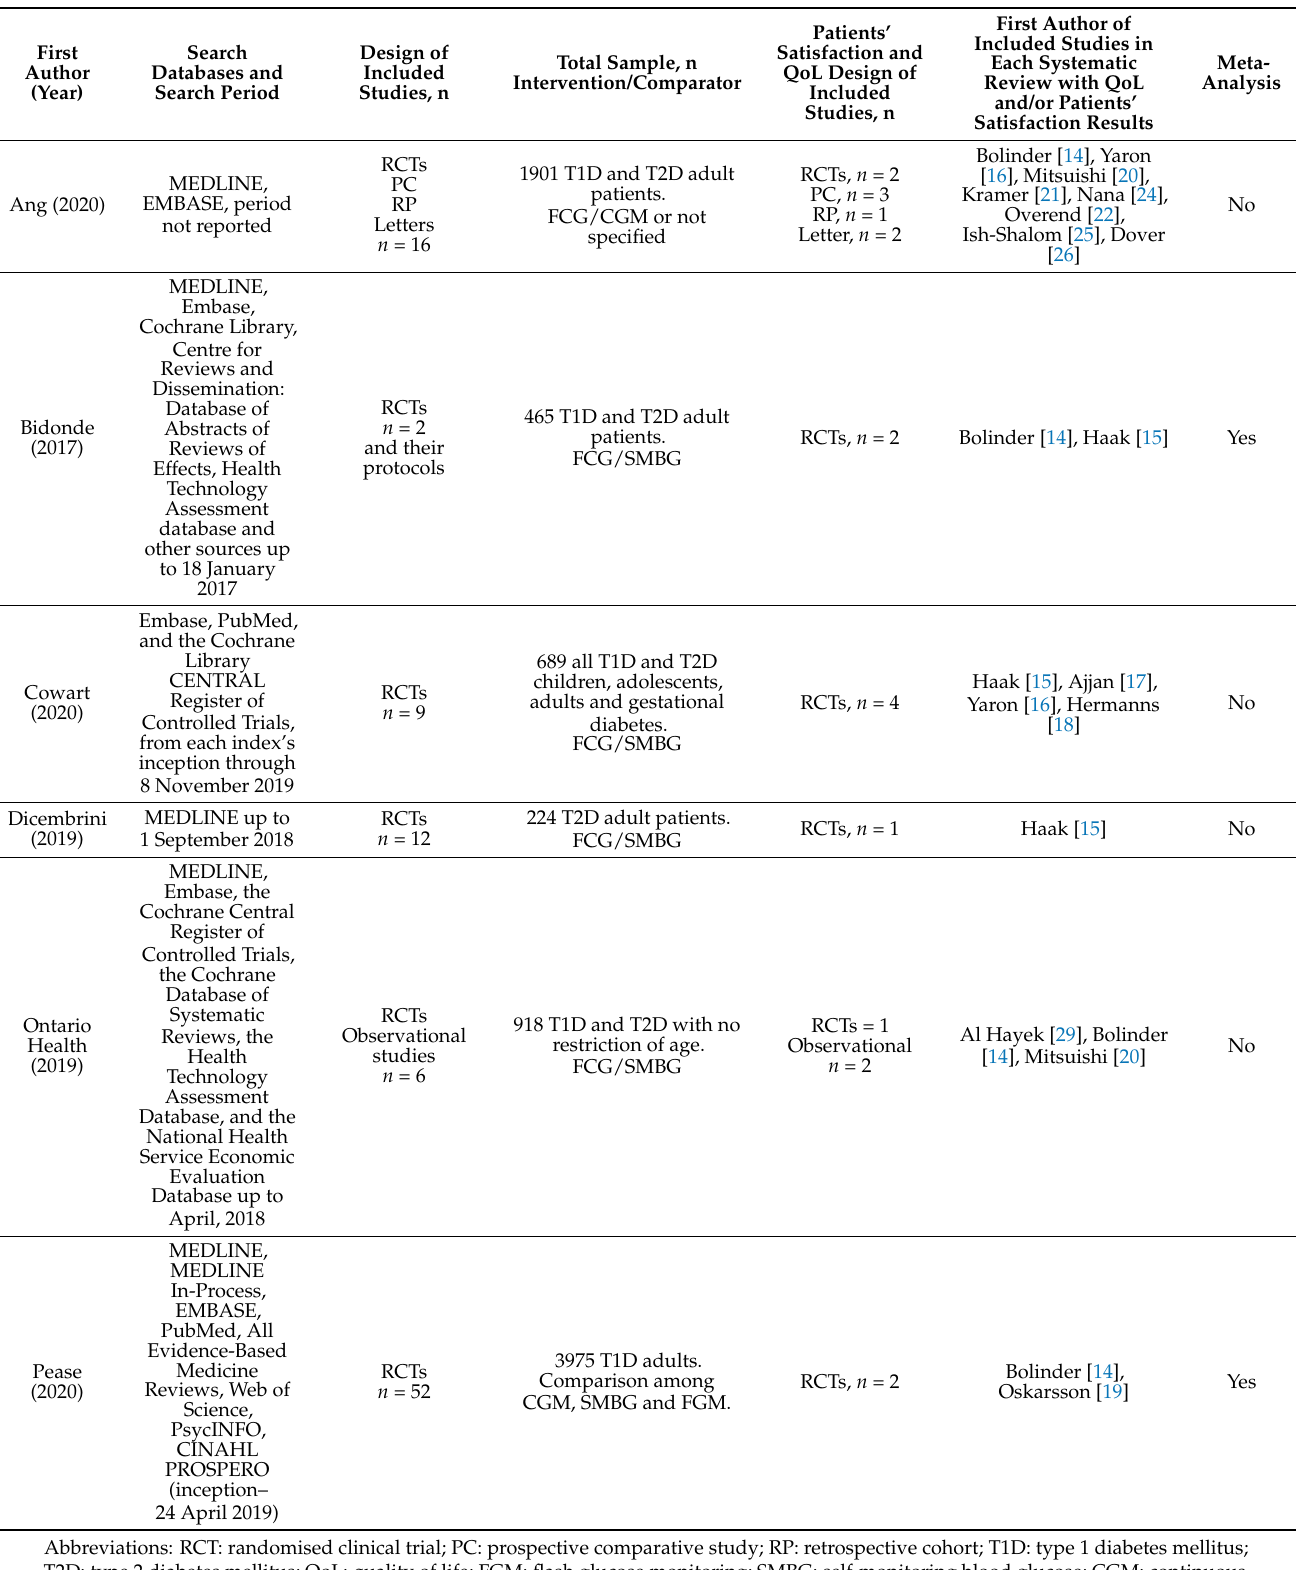
Table 2. Characteristics of the included systematic